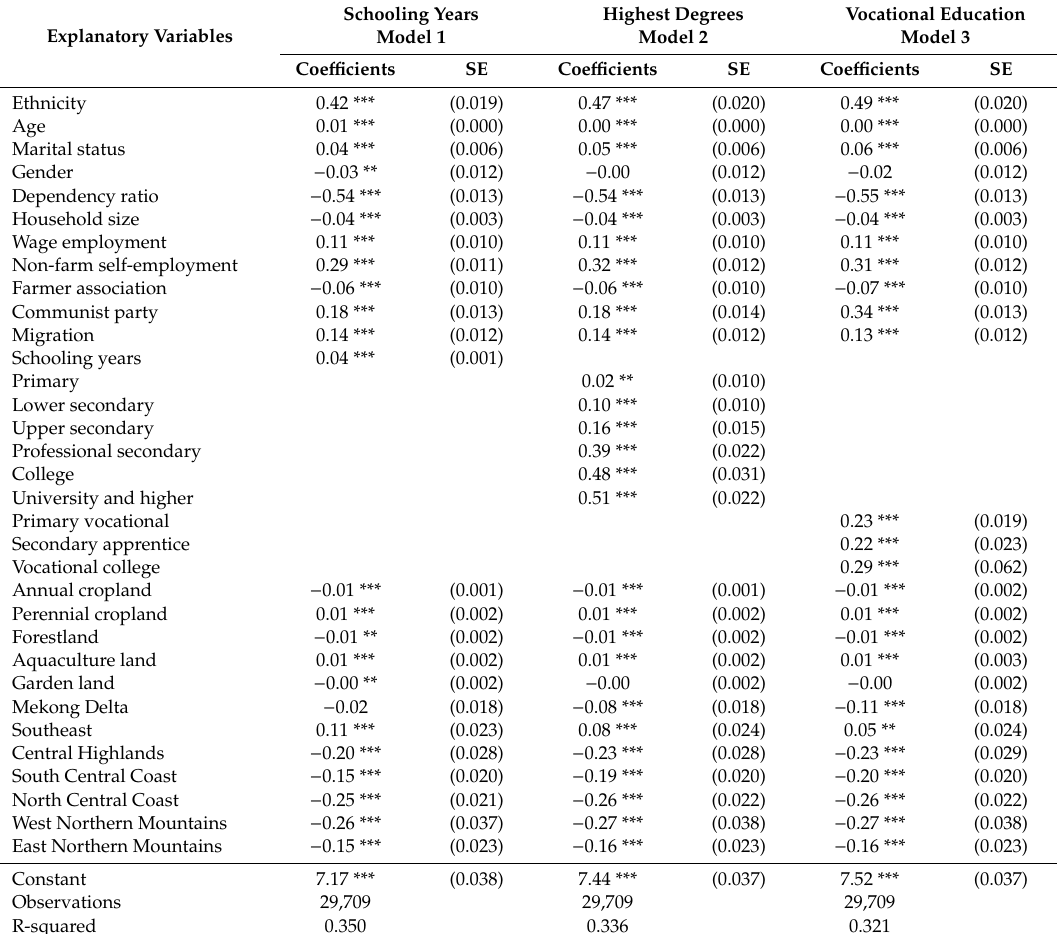
Table 3. The e ff ect of education on household